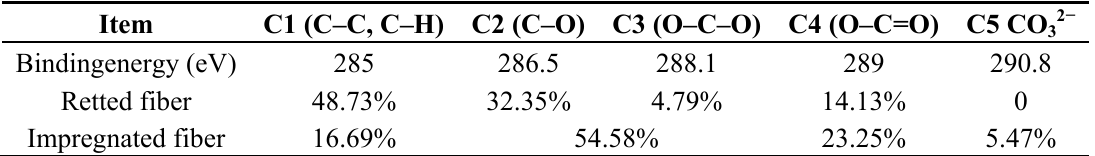
Table 2. C 1s component intensities of INI kenaf bast fibers with the chemically retted fibers used as control.